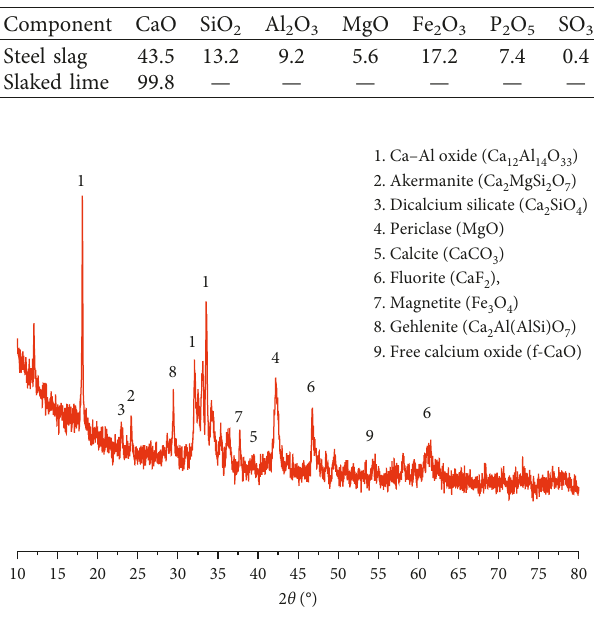
Figure 1: Mineral composition of steel slag. Table 2: The content of purified medium of the strain.